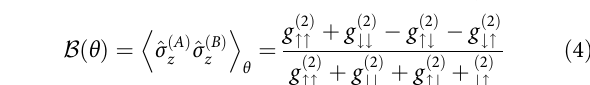
Fig. 3 Coherent control of atomic spin in a metastable helium scattering halo. Rabi oscillation in the population fraction from a single rotation pulse with an amplitude of 0 : 85 ð 4 Þ and effective Rabi frequency Ω ′ ¼ 2 π (cid:8) 50 : 3 ð 3 Þ kHz . The Larmor precession frequency of the atomic spins is Ω π (cid:8) 1 : 4 MHz for a fi eld of (cid:5) 0 : 5 G . The error bars of the data points L (cid:4) 2 indicate statistical variations around different regions in the scattering sphere and the solid lines are sine fi ts to